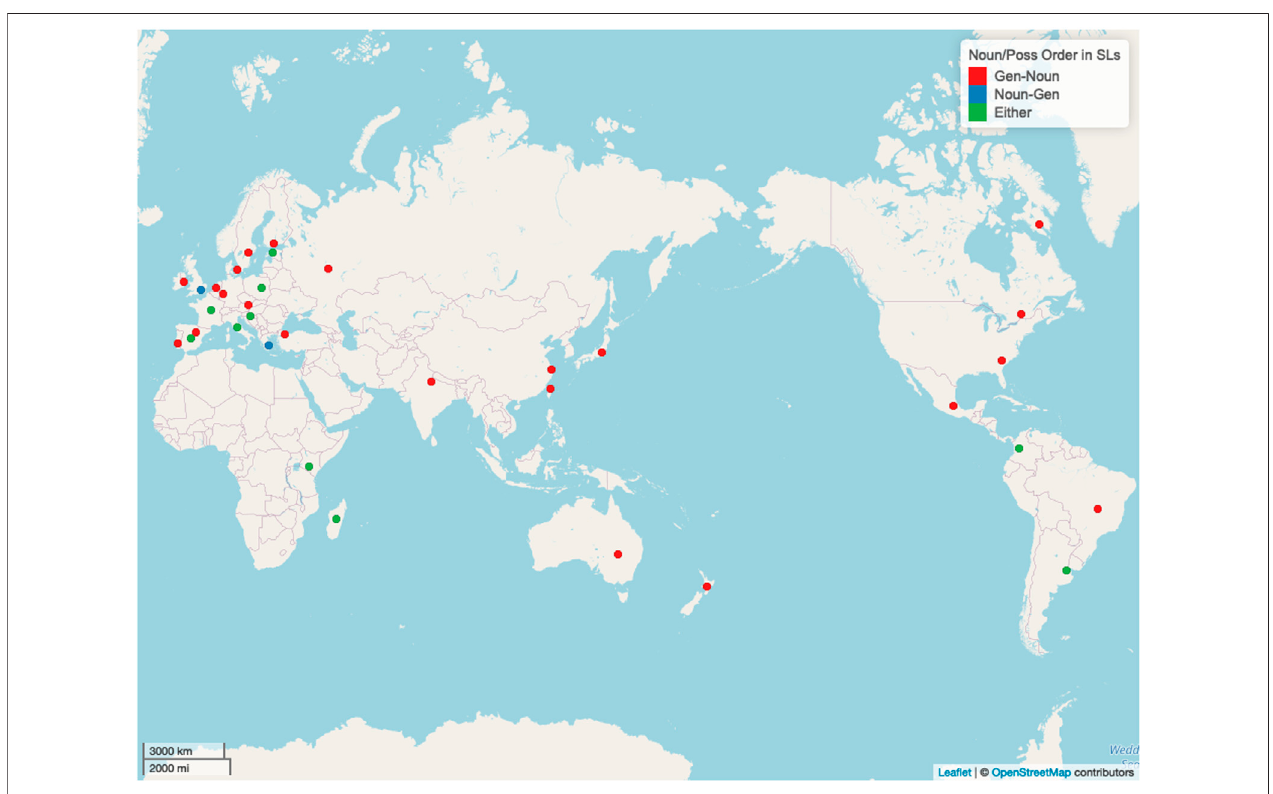
FIGURE 6 | Map of noun/genitive order in sign languages.